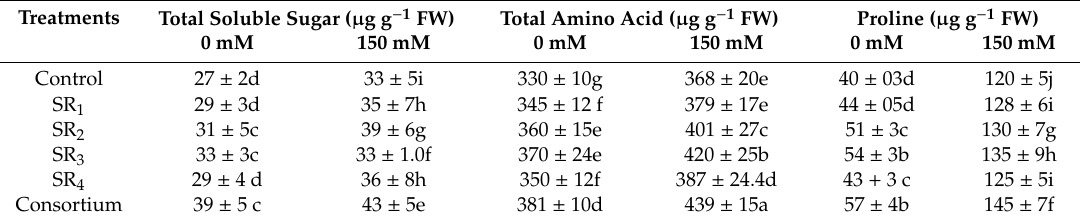
Table 6. E ff ects of halotolerant PGPR on the total soluble sugar, amino acid, protein, and proline contents of wheat plants grown under salinity stress.